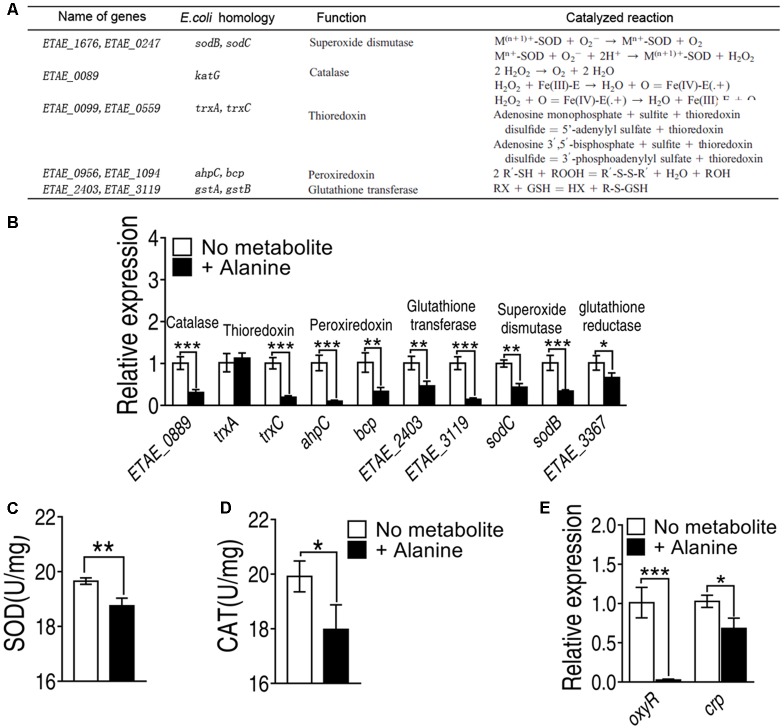
Alanine represses genes with antioxidant functions (A) Genes with antioxidant functions present in E. tarda, their homologues in Escherichia coli, their functions and the catalyzed reactions of the encoded enzymes. (B) Transcriptional level of genes of major classes of antioxidants. (C) SOD activity and (D) catalase activity in the presence of exogenous alanine (40 mM). (E) Transcriptional level of oxyR and crp in the presence of alanine. ∗p < 0.05, ∗∗p < 0.01, and ∗∗∗p < 0.001 as determined by Student’s t-test.